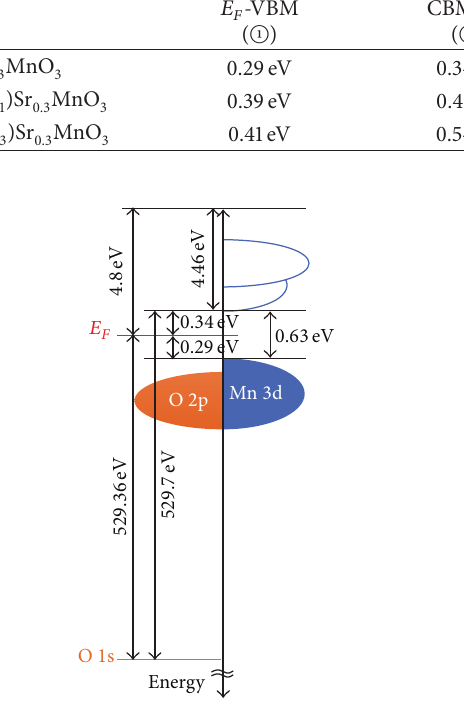
)Sr MnO , (La Gd )Sr MnO , and (La 0.7 0.3 3 0.6 0.1 0.3 3